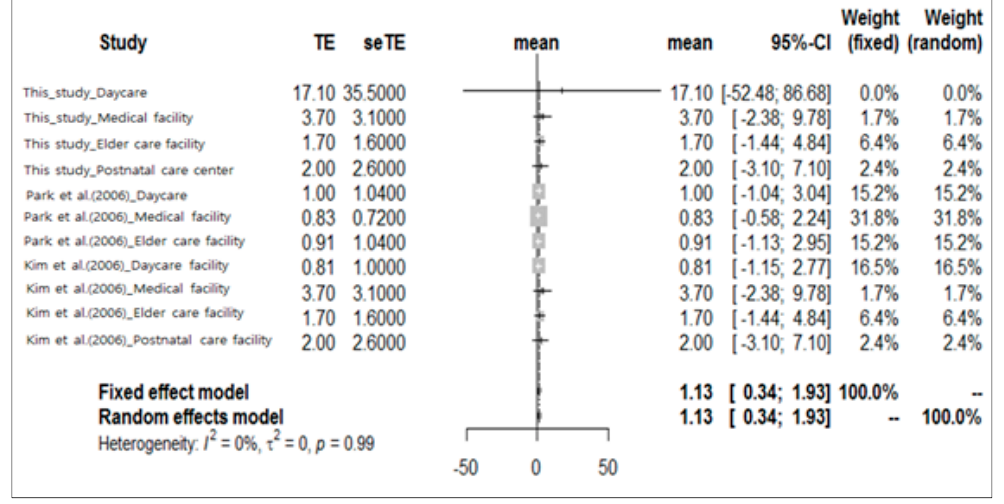
Figure 4. Pooled indoor/outdoor concentration ratios from previous studies.